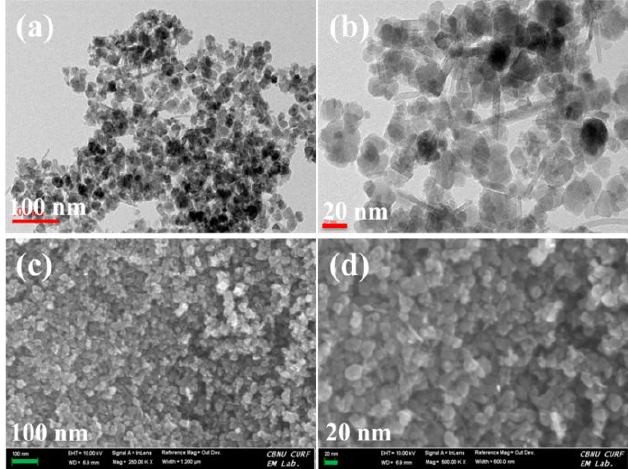
Figure 5. ( a , b ) TEM images and ( c , d ) field emission scanning electron microscope (FE-SEM) images of Fe 3 O 4